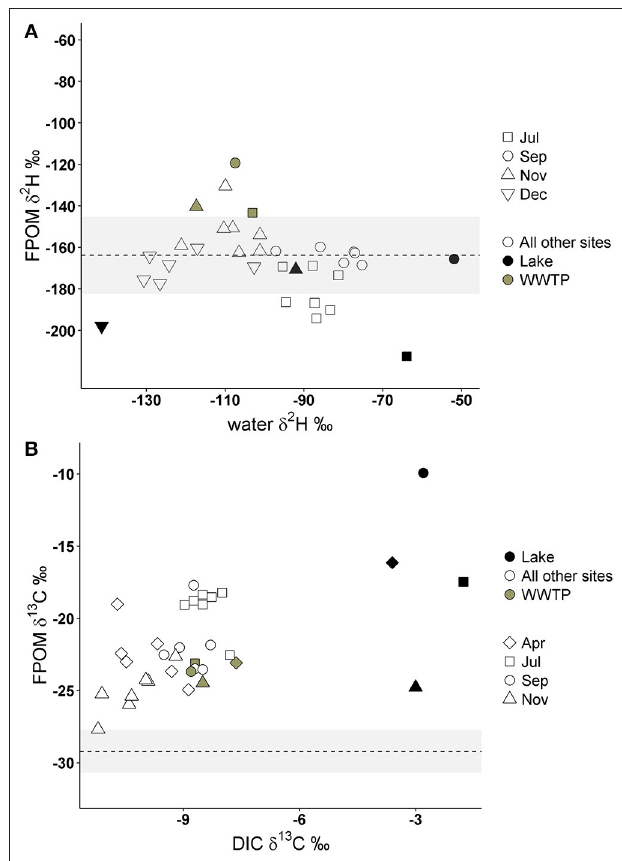
FIGURE 5 | Deuterium values of FPOM compared to deuterium of Jordan River water (A) and FPOM δ 13 C values compared to δ 13 C of Jordan River dissolved inorganic carbon (DIC; B ). The dashed lines and gray areas represent the average deuterium and carbon isotope values of terrestrial sources collected in this study (see Table 1 ). Gray circles represent FPOM collected from WWTP effluent, black circles from Utah Lake, and open circles are FPOM collected from all other sites.